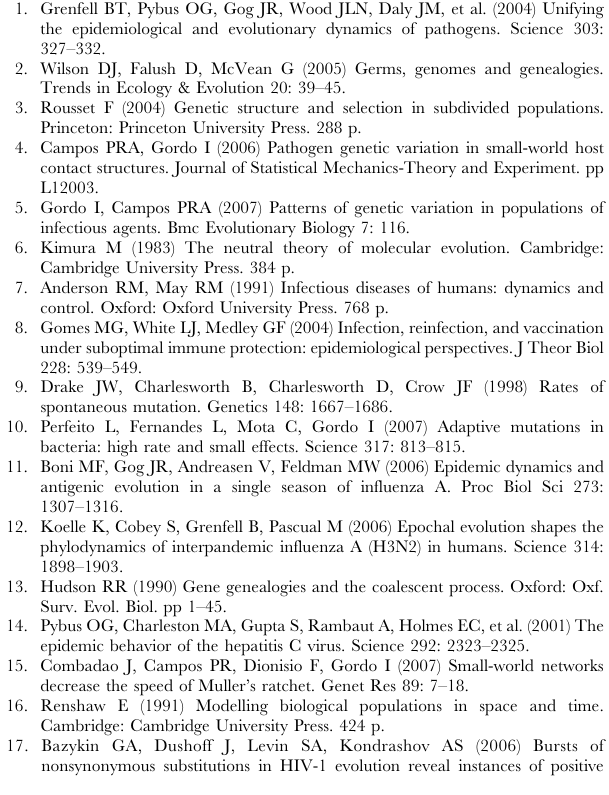
pattern is expected, as in Figure 4. Figure S1 Time plot of the pattern of diversity during the replacement of a new strain. On the left scale of the plot diversity (gray line) and Tajima’s D (filled triangles). On the right scale we plot the total frequency of infection (dashed line) and the frequency of hosts infected with new selected strain (filled line). Parameters